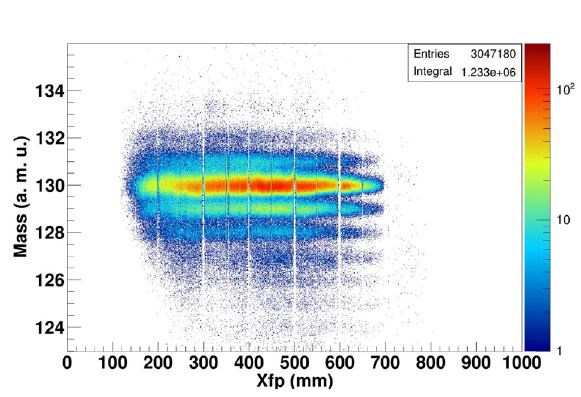
Figure 2. Mass vs position in the focal plane (Xfp) obtained in the 197 Au + 130 Te [20] at E lab = 1.07 GeV after the trajectory re- construction and software-based correction of nonlinear distor- tions of ion trajectories in PRISMA for the Te-like ions.